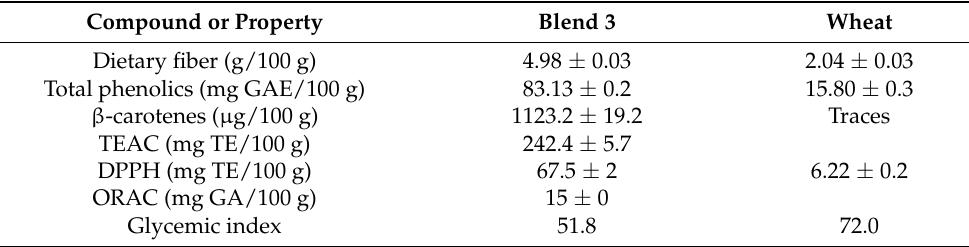
Table 8. Fiber, total phenolic compounds, β -carotenes, antioxidant capacity and glycemic index of the bread made with blend